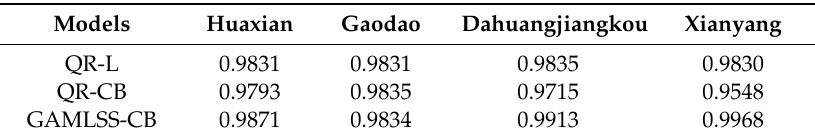
Table 5. Filliben correlation coe ffi cient of each station.